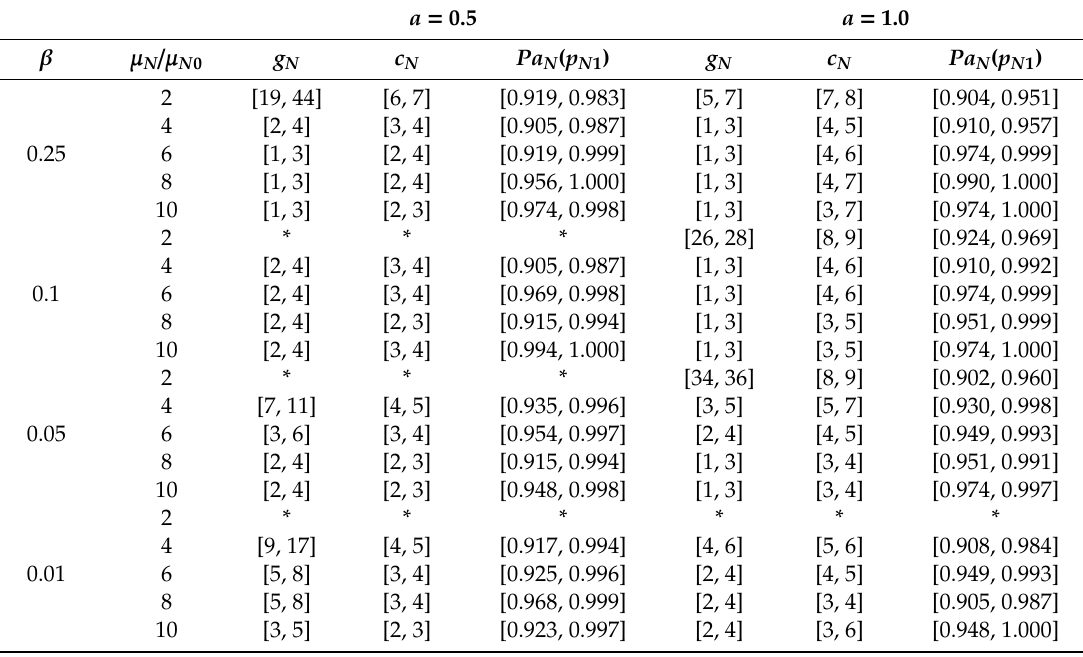
Table 1. Optimal parameters of the proposed GASP under neutrosophic statistics when r N = [10, 12] and δ N = [0.9, 1.1].